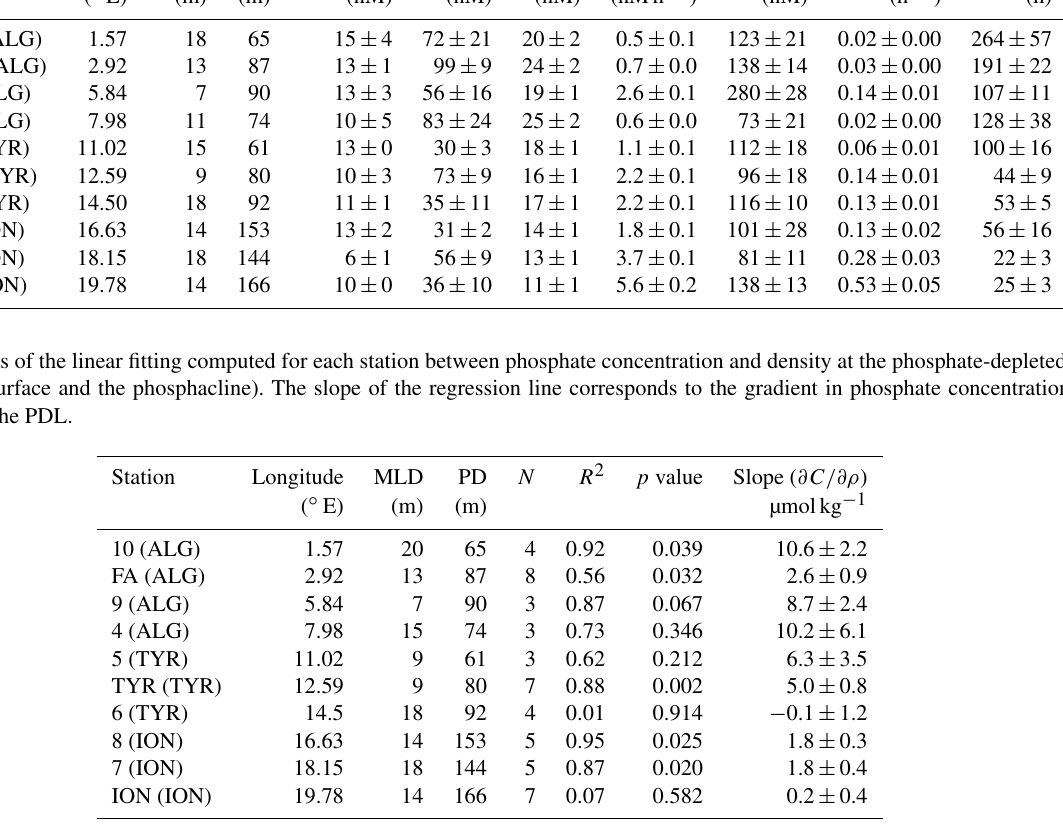
Table 2. Summary of biogeochemical features of the phosphorus pool inside the phosphate-depleted layer at each investigated station. See Table 1 and text (Sect. 2.5) for details on the calculation of the phosphacline depth (PD). Station